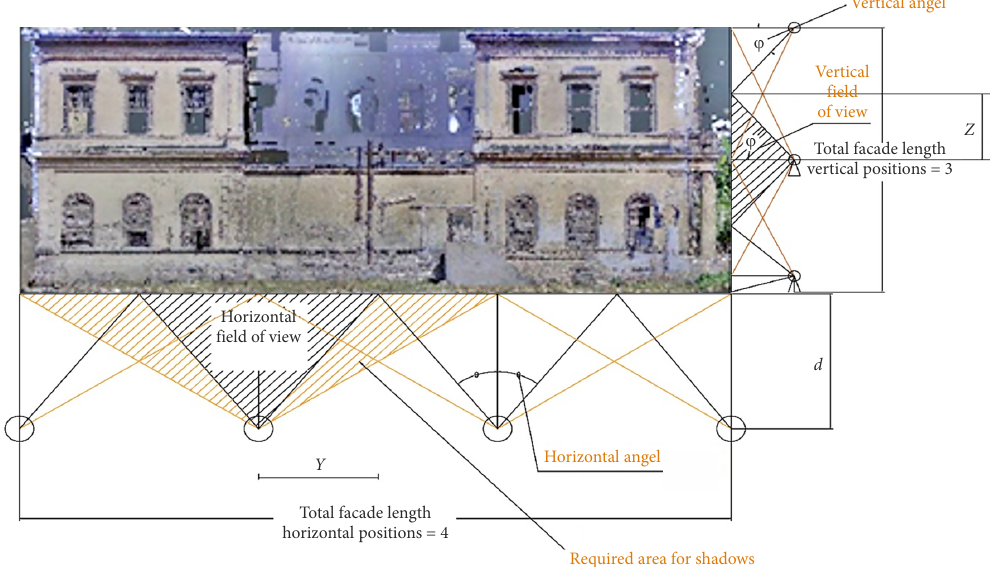
Required area for shadows